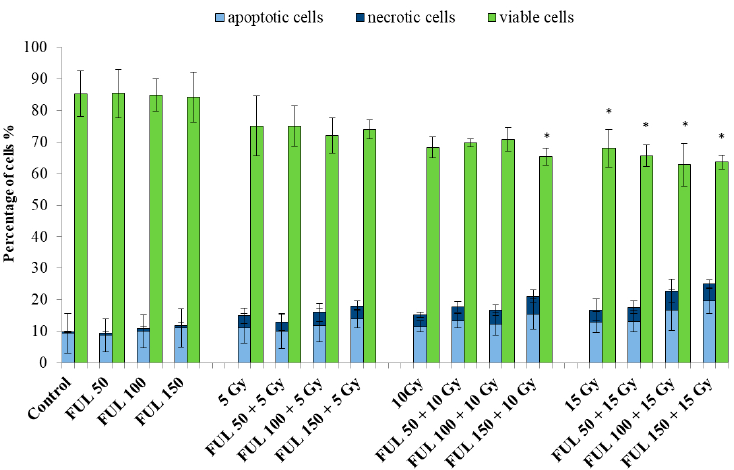
Figure 8. Viability of PBMCs irradiated (5, 10, and 15 Gy) in the absence or presence of fullerenol C 60 (OH) 36 (50–150 mg / L) after 24-h-post-irradiation incubation (37 ◦ C, 5% CO 2 atmosphere, 100% relative humidity). Preincubation with fullerenol lasted 1 h. The cells were stained with PI and calcein-AM (c-AM). Bars represent mean values with standard deviations. Asterisks are used to mark values that are statistically di ff erent in comparison with control values (* p < 0.05). All experiments were repeated 3–6